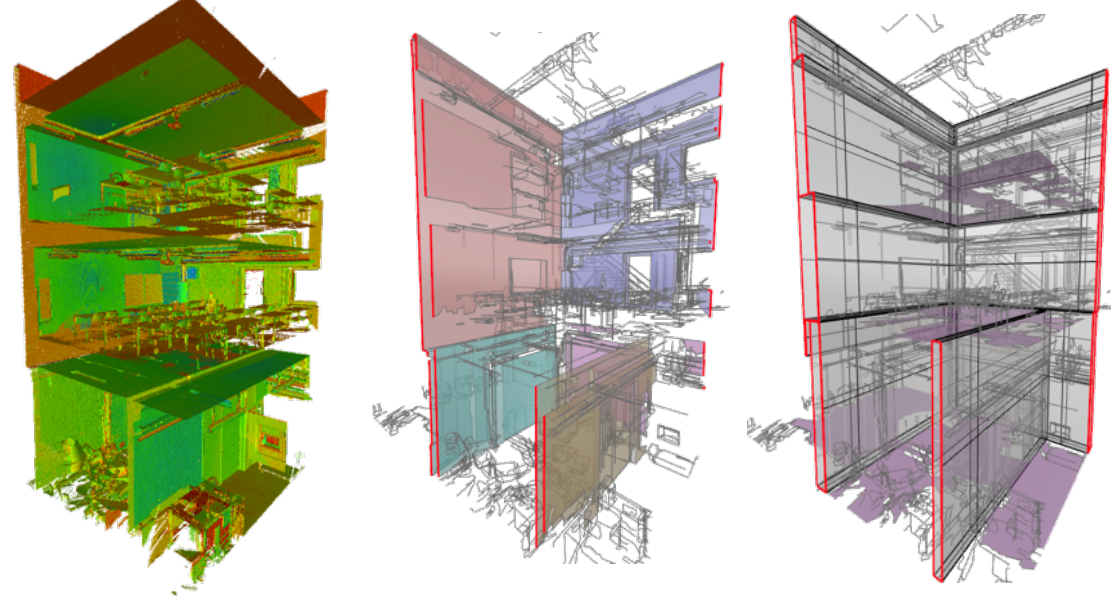
Figure 1: Overview of the intermediate results of the presented Scan-to-BIM procedure: unstructured point cloud (left), extracted classified clustered planar wall segments (mid) and the reconstructed LOD200 walls